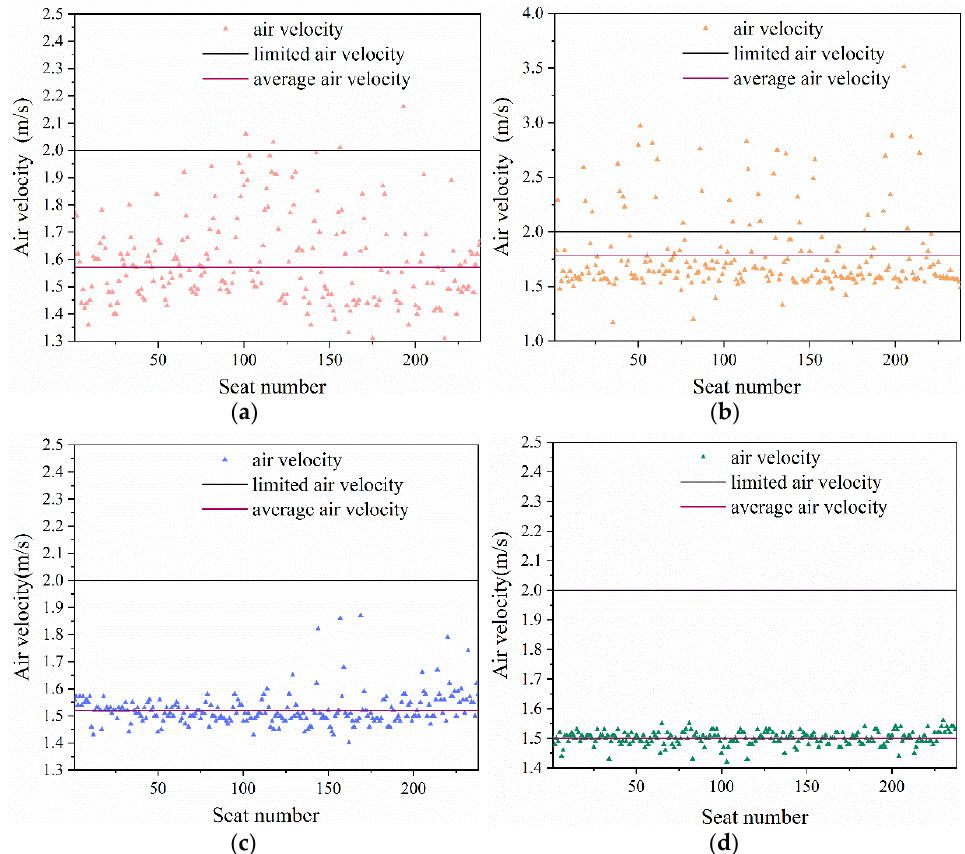
Figure 14. Scatter plot of air velocity at the diffuser centre. ( a ) case A, ( b ) case B, ( c ) case C, ( d ) case D.